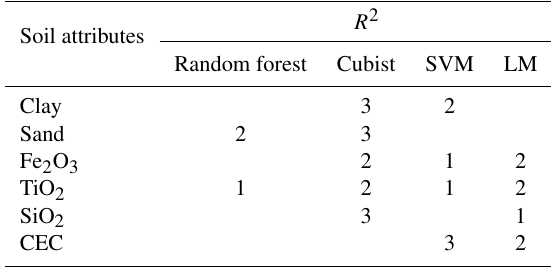
Table 7. Number of times that each model achieved the best perfor- mance for each soil